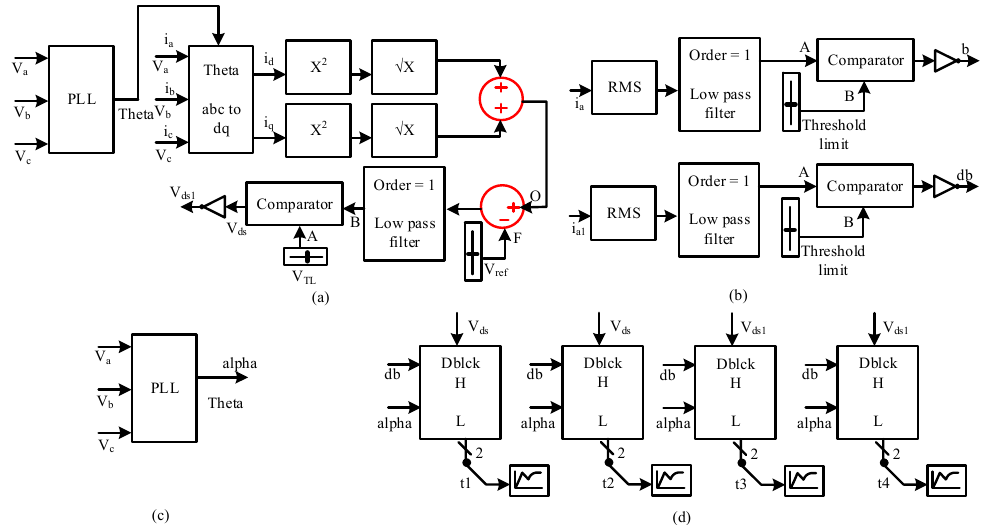
Figure 16. Control scheme of SSTS signal ( a ) voltage detection; ( b ) current direction and zero-crossing; ( c ) synchronizing; ( d ) firing control logic [18].